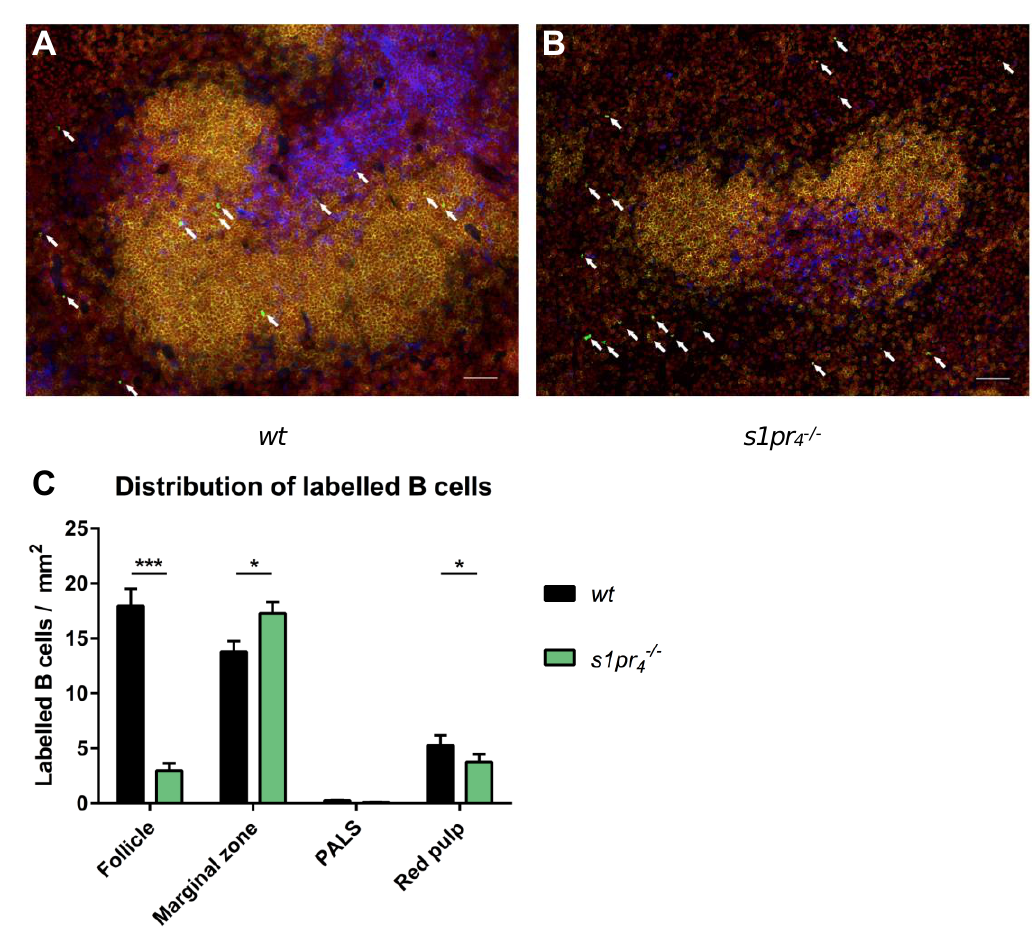
Figure 4. Localization of intraperitoneal transferred peritoneal B cells within the spleen after LPS stimulation in vivo. The localization of s1pr 4−/− ( A ) and wt ( B ) i.p. transferred peritoneal B cells within the spleen was analyzed using fluorescence microscopy. Representative immunofluorescence-stained splenic sections from LPS-stimulated wt mice after adoptive cell transfer of wt or s1pr 4−/− peritoneal cells (white bar equals 50 µm). The signal intensity of CFSE from labeled cells was enhanced using polyclonal anti-FITC-Alexa488 (green). Tissue sections were additionally stained with anti-B220 (yellow) and anti-CD4 (blue), while nuclei were stained with Draq5 (red). Transferred B cells were identified as B220 + CFSE + (white arrows). ( C ) Quantification of the exact localization of transferred B cells within the different splenic and intestinal com-